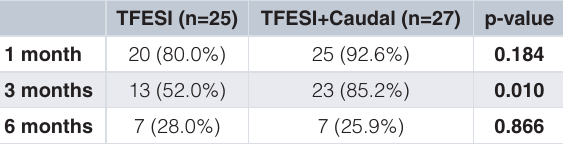
Table 2. The number of patients with a decrease in VNRS of 30% or greater from baseline at each follow-up period in chronic lumbosacral radicular pain.